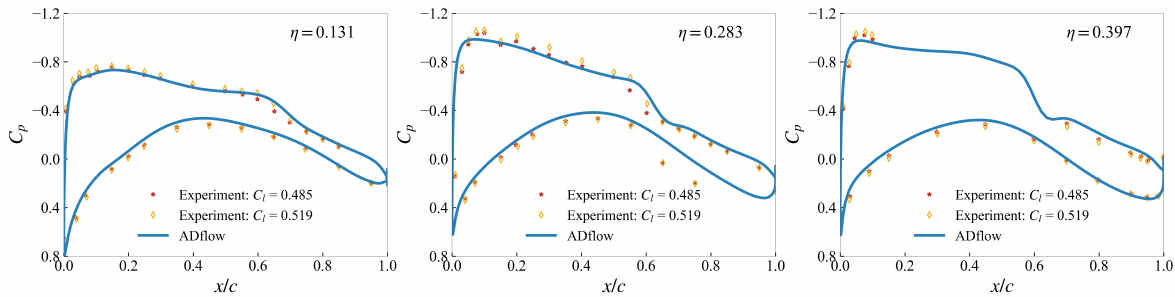
Figure 7. The comparison of pressure distribution between ADflow solution and experiment ( η = 2 y / b is the span).